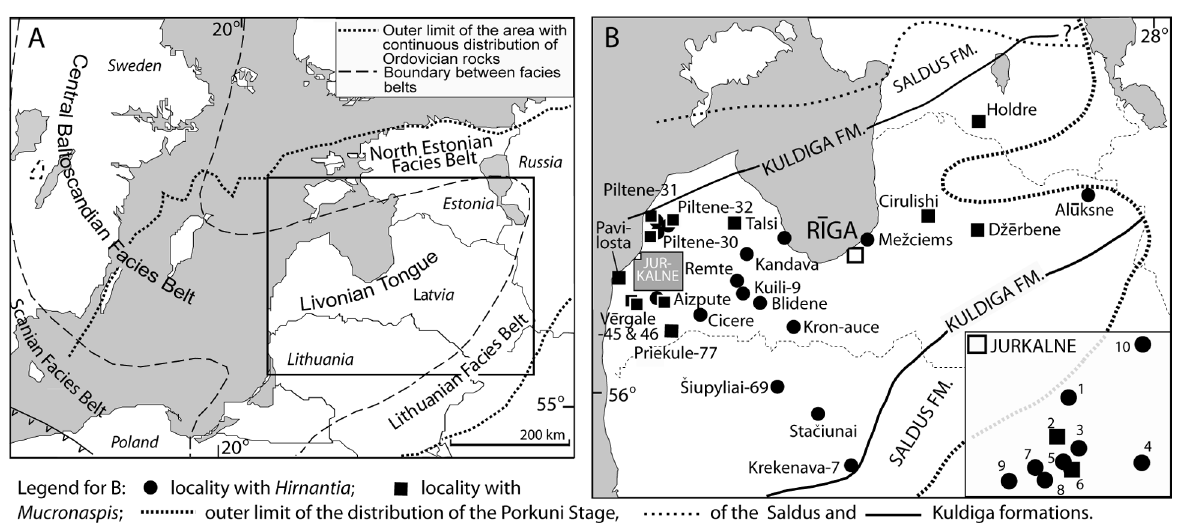
Fig. 1. A , distribution of the Ordovician rocks and facies belts in the Baltic Basin; B , location of drill core sections with the limits of the distribution areas of the Kuldiga and Saldus formations. Drill cores: 1, Stirnas-18; 2, Pliekalne-14; 3, Di(cid:158)rungi-17; 4, Vilcini-19; 5, Adze; 6, Dreimani; 7, Riekstini-15; 8, Me(cid:158)mali-16; 9, Me(cid:158)vagari-13; 10,